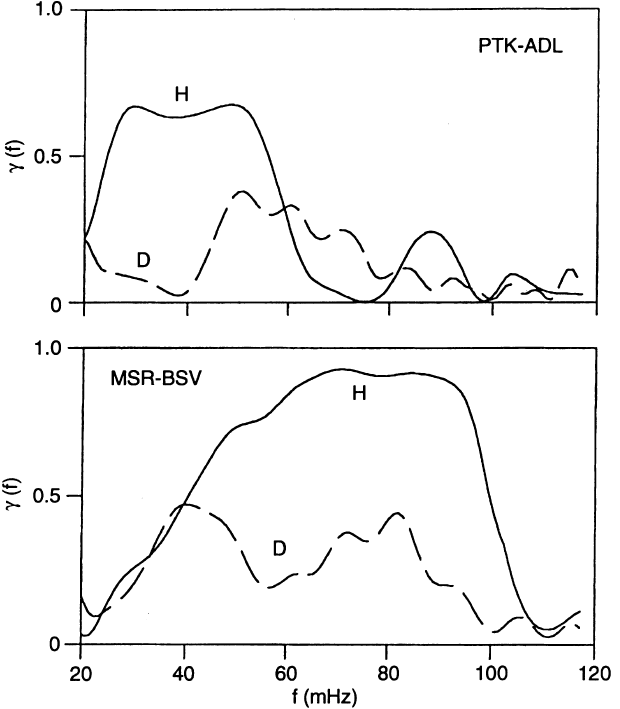
Fig. 4. Coherency coe(cid:129)cients c (cid:133) f (cid:134) for the event 1 for H and D components between the conjugate stations PTK-ADL ( L (cid:25) 2 : 1) and MSR-BSV ( L (cid:25) 1 : 6)